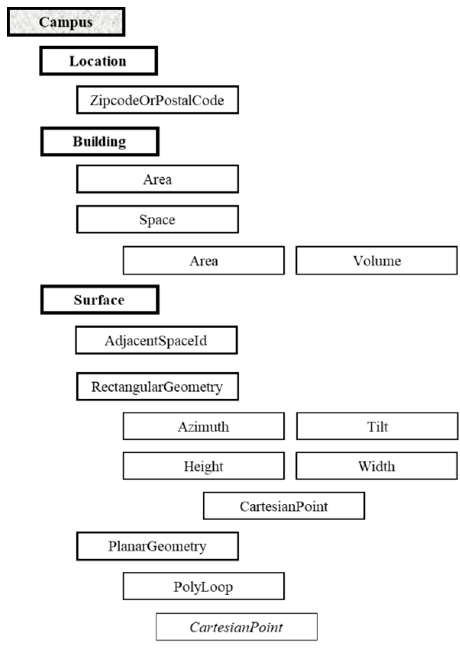
Figure 6. GbXML Structure. The main fields in the structure are highlighted in bold.